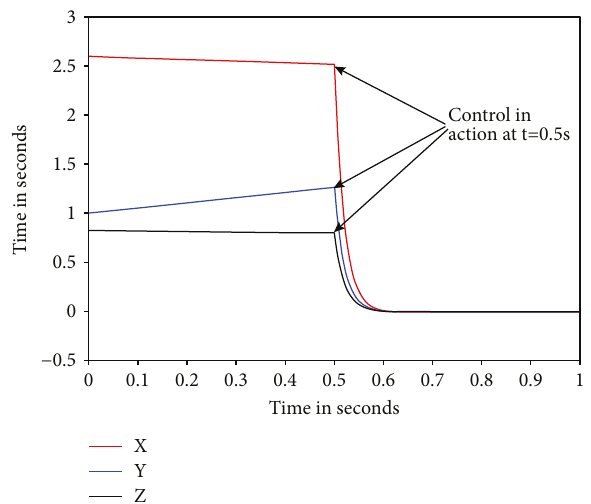
Figure 10: Time history of the delay (3) with controllers in action at t = 0 5 s using Xilinx system generator